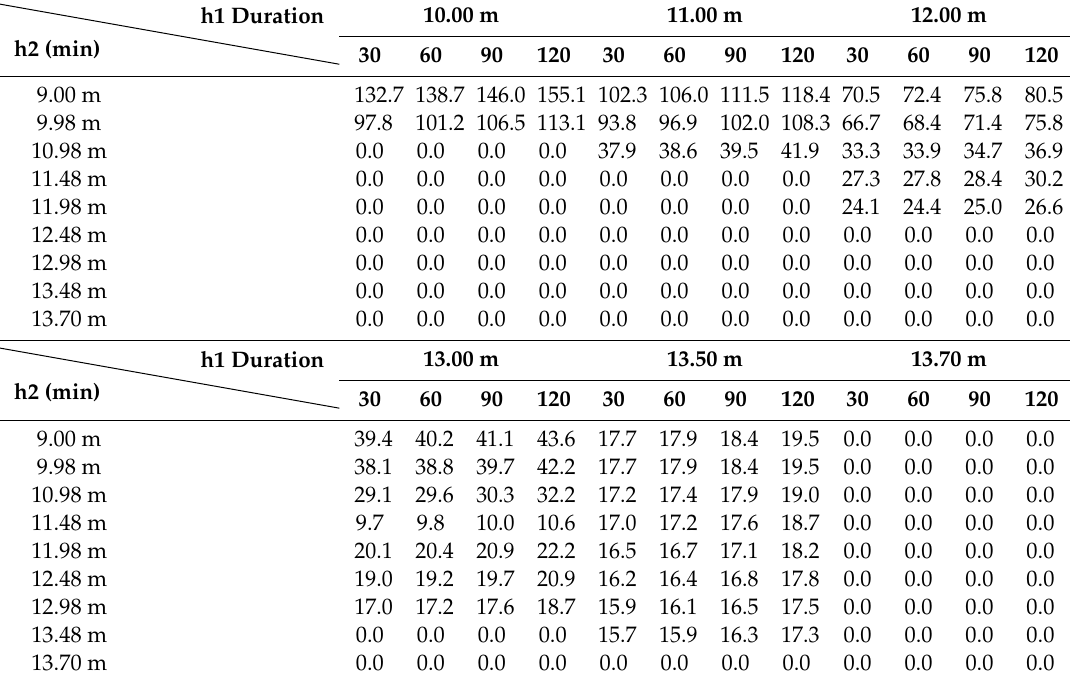
Table 7. Rainfall depth according to duration for evacuation warning criteria (unit: mm).